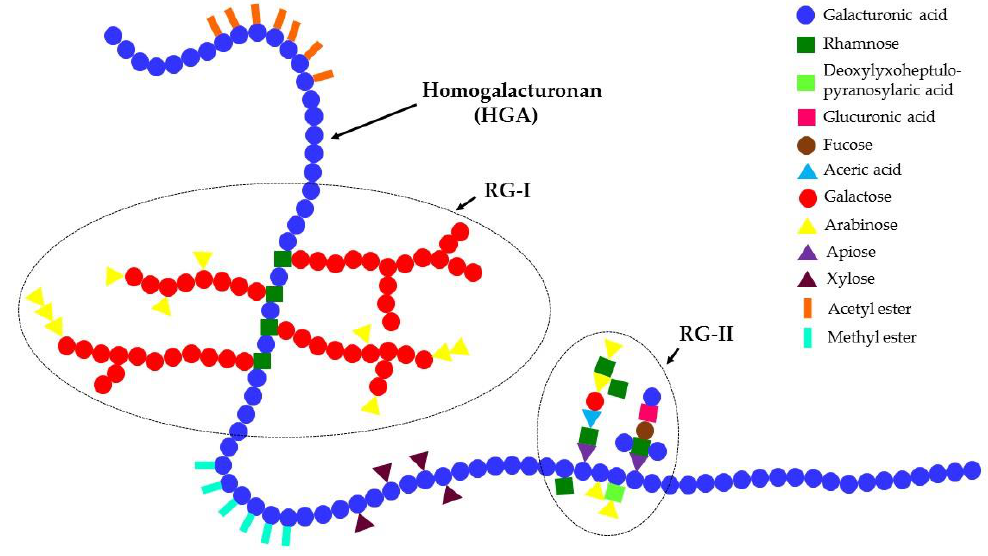
Figure 1. A scheme of the primary structure of pectins.